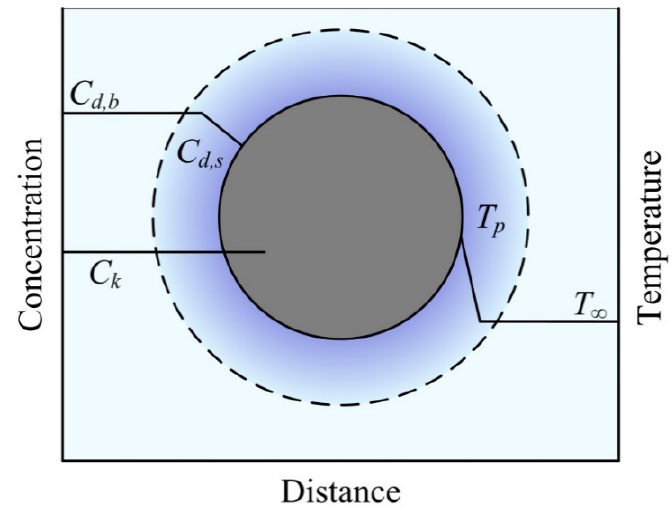
Figure 3. A reacting particle in the multiple surface reactions model [42]: T p —droplet temperature; T∞ —ambient gas temperature; C d,b and C d,s —concentration of the diffusion-limited species; C k —concentrations of all other species.